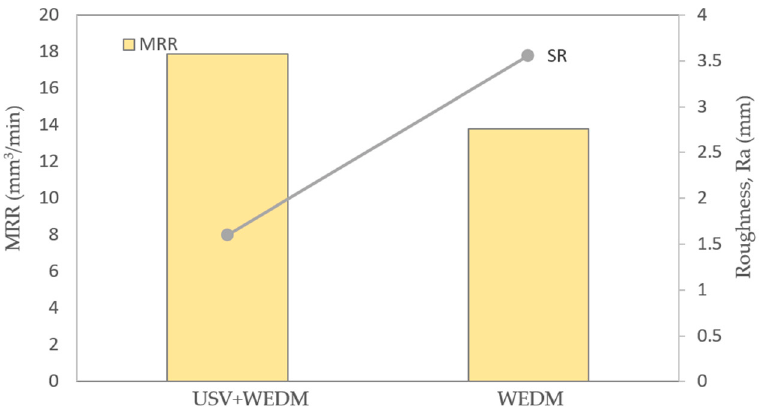
Figure 8 . MRR and Surface Roughness for USV - WEDM and Normal WEDM . Figure 8. MRR and Surface Roughness for USV-WEDM and Normal